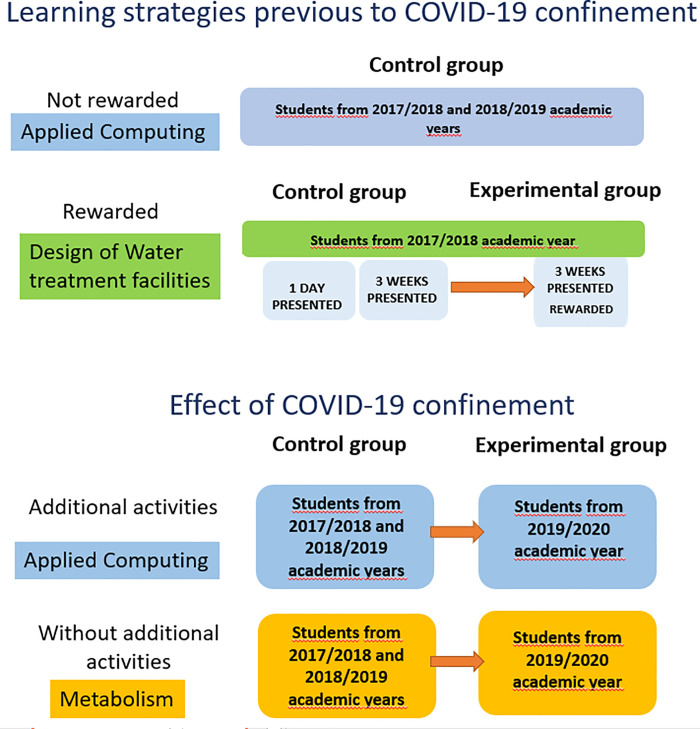
Description of the experiment.